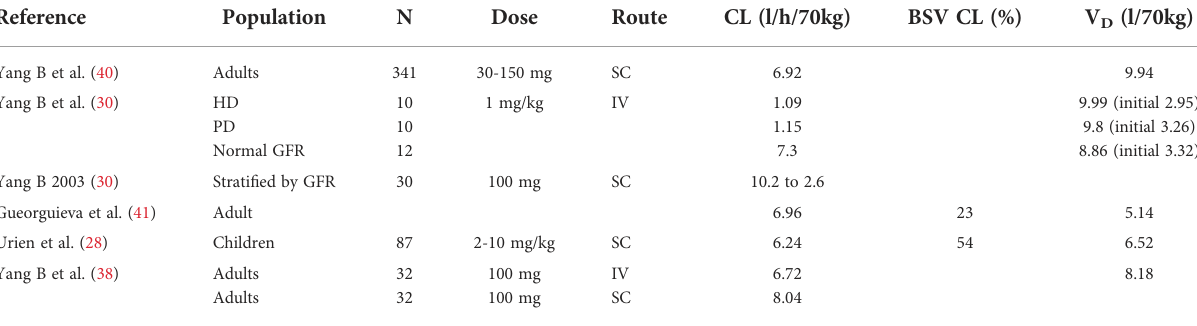
TABLE 2 Published PK and population PK parameter values for anakinra.